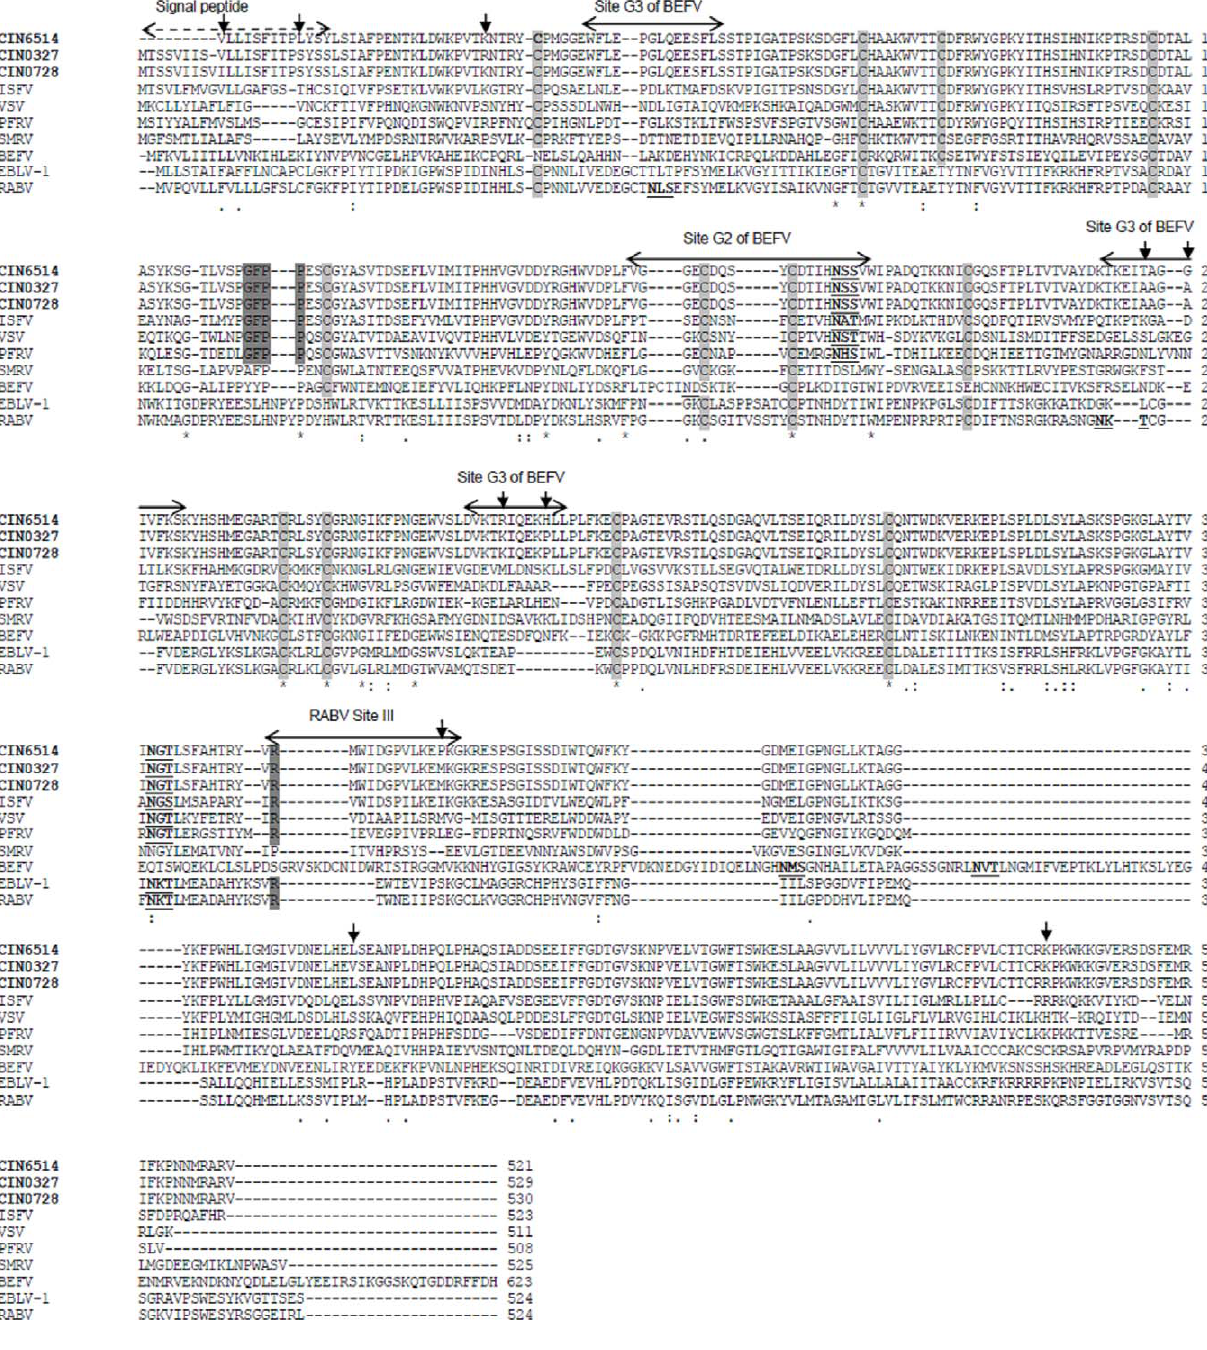
Figure 6. Alignment of G protein of representative CHPV whole genome isolates (in bold) with other representative rhabdoviruses. BEFV antigenic sites and RABV antigenic sites are indicated by arrows above the sequence. Functionally important motifs are highlighted in grey and putative glycosylation sites are underlined. The signal peptide is indicated by dashed arrow. Highly conserved cysteine residues are highlighted in faint grey. Mutations within CHPV isolates are indicated by downward